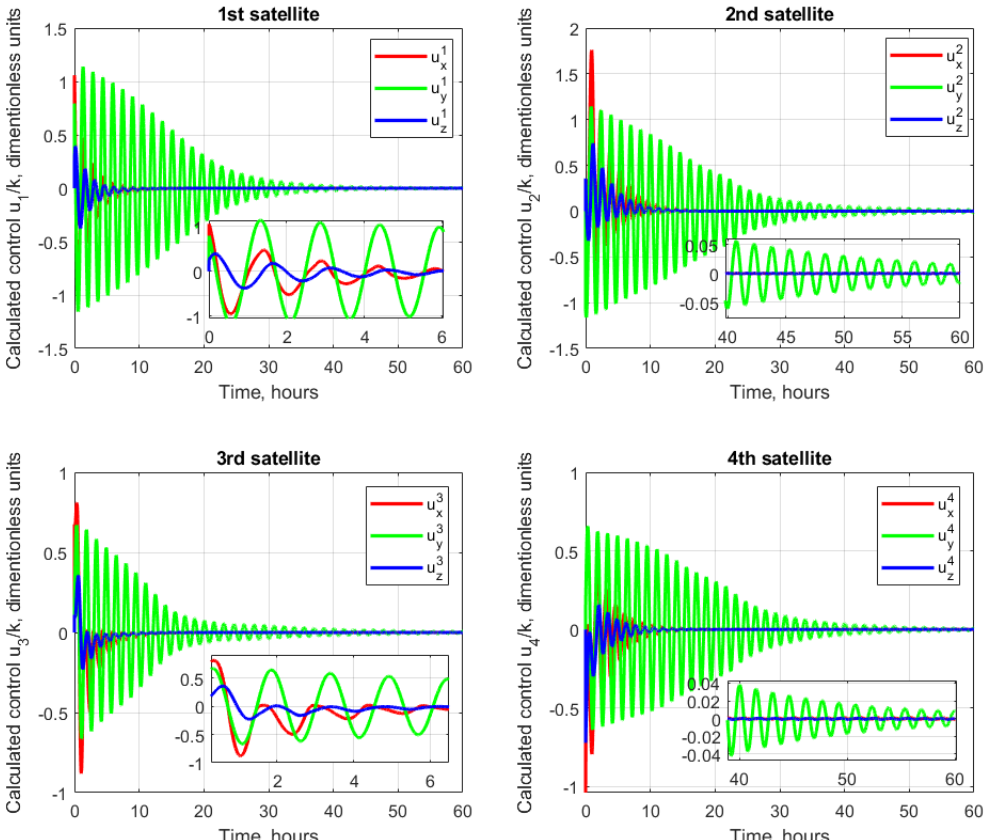
Figure 6. Calculated control vector according to Equation(9).